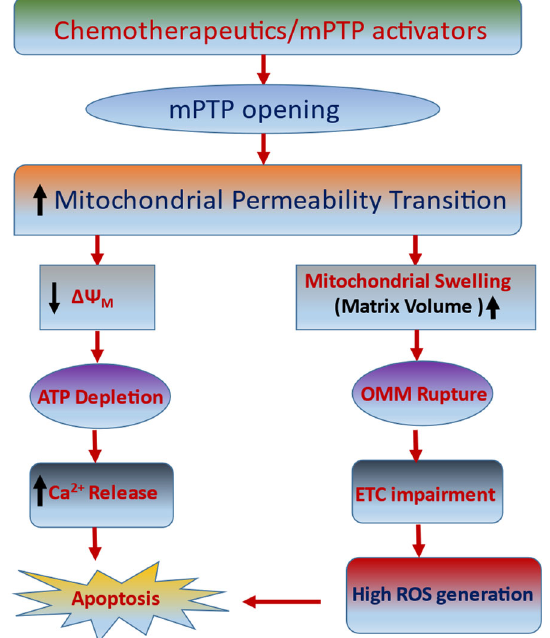
Figure 2. Plausible role of chemotherapeutics or modulators targeting mPTP in cancer. In cancer therapy, mPTP remains open, which causes the mitochondrial membrane potential to deteriorate followed by disruption of the OMM. This mitochondrial impairment results in the depletion of ATP generation, defective ETC, and enhanced Ca 2+ flux, which leads to a massive generation of ROS and ultimately causes apoptosis.